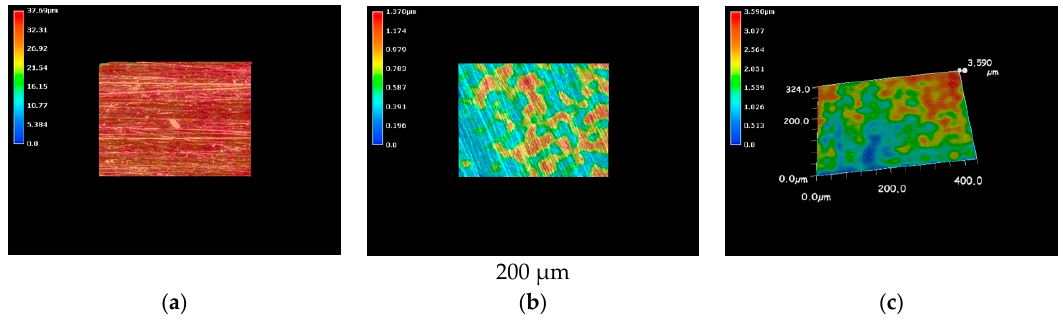
Figure 5. The 3D images by the optical microscopy for cupronickel specimens. ( a ) Before immersion; ( b ) resident microbiota; ( c ) E-coli .